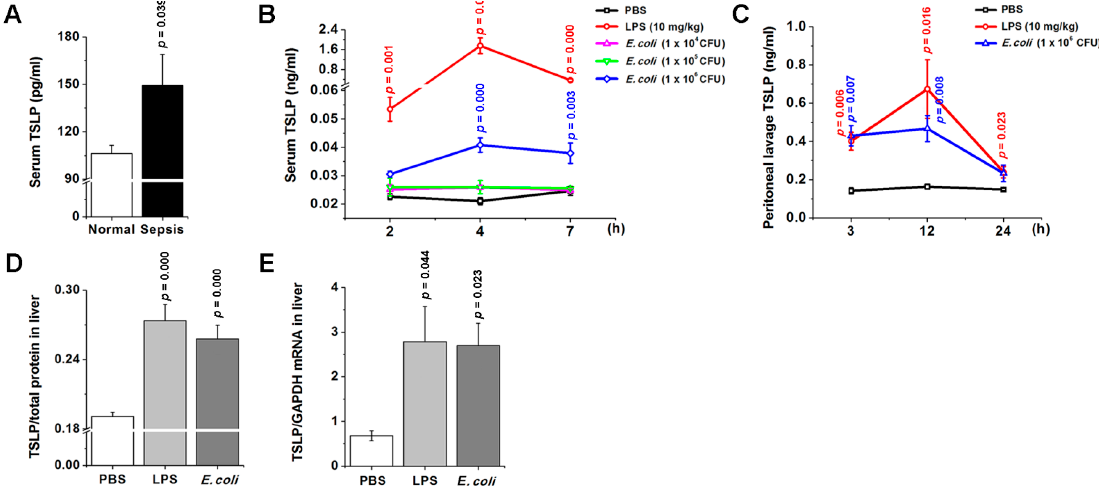
Figure 1. TSLP is associated with sepsis. ( A ) TSLP levels in serum of patients with sepsis were analyzed by ELISA. Normal (Healthy volunteers, n = 20); Sepsis (Patients with sepsis, n = 30). A p value indicates the significant difference between normal and sepsis ( B ) TSLP levels were analyzed in serum of mice following LPS or E. coli injection by ELISA. ( C ) TSLP levels were analyzed in peritoneal lavage of mice following LPS or E. coli injection by ELISA. ( D ) TSLP protein levels were analyzed 12 h after LPS (10 mg/kg) or E. coli (1 × 10 6 CFU) injection by ELISA. ( E ) TSLP mRNA expression was analyzed 12 h after LPS (10 mg/kg) or E. coli (1 × 10 6 CFU) injection by real-time PCR ( n = 10/group). A p value indicates the significant difference between PBS and LPS. PBS, phosphate-buffered saline; LPS, lipopolysaccharide; TSLP, thymic stromal lymphopoietin.